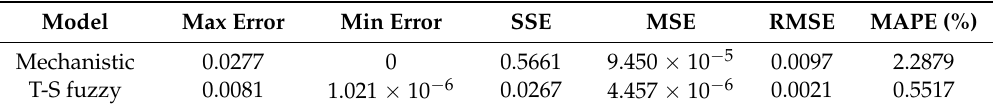
Figure 13. Modeling results under normal power generation condition. ( a ) Rotation speed curves comparisons; ( b ) Rotation speed errors of two models. Table 3. Performance indexes of the two models under normal power generation condition.